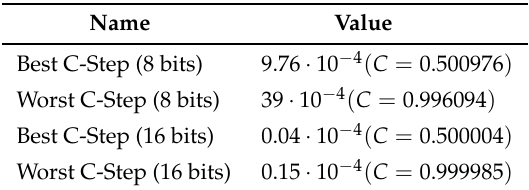
Table 2. Resampling factor